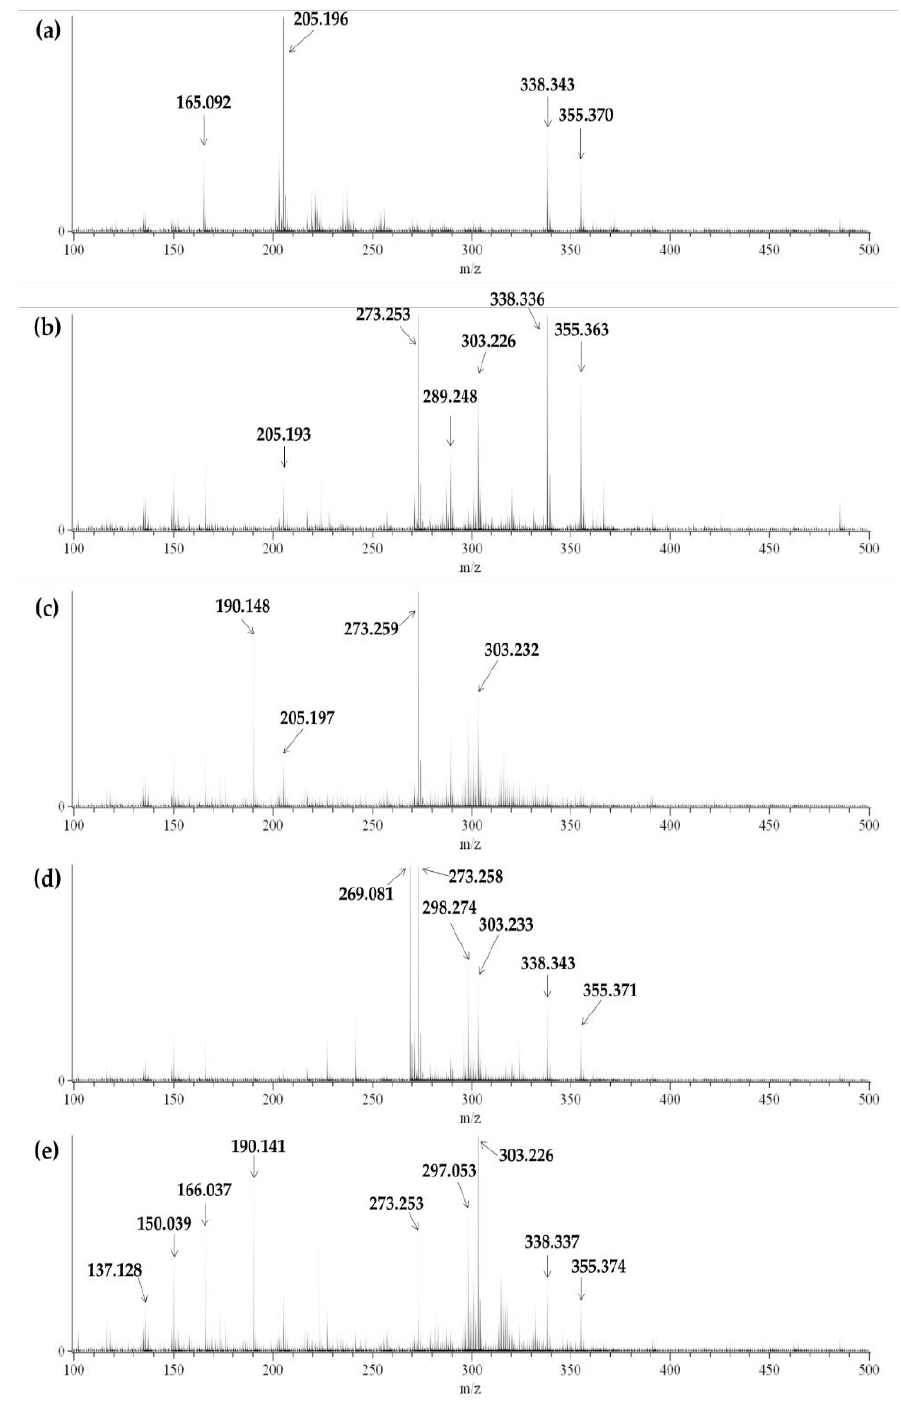
Figure 3. Representative overlapped mass spectra for each species; ( a ) Chamaecyparis obtusa (Co) Siebold & Zucc., ( b ) Larix kaempferi (Lk), ( c ) Pinus densiflora (Pd) Sieb. et Zucc., ( d ) Pinus koraiensis (Pk) Sieb. et Zucc., and ( e ) Pinus thunbergii (Pt) Parl.